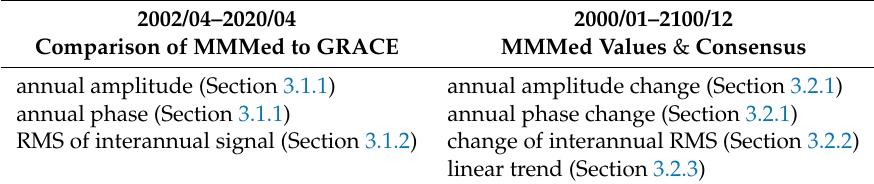
Table 1. Overview over the different signal components analyzed for different time